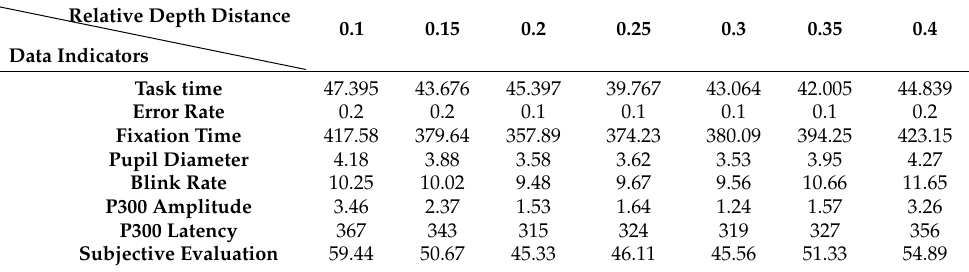
Table 21. Subjective and objective data at depth distances at different relative positions.